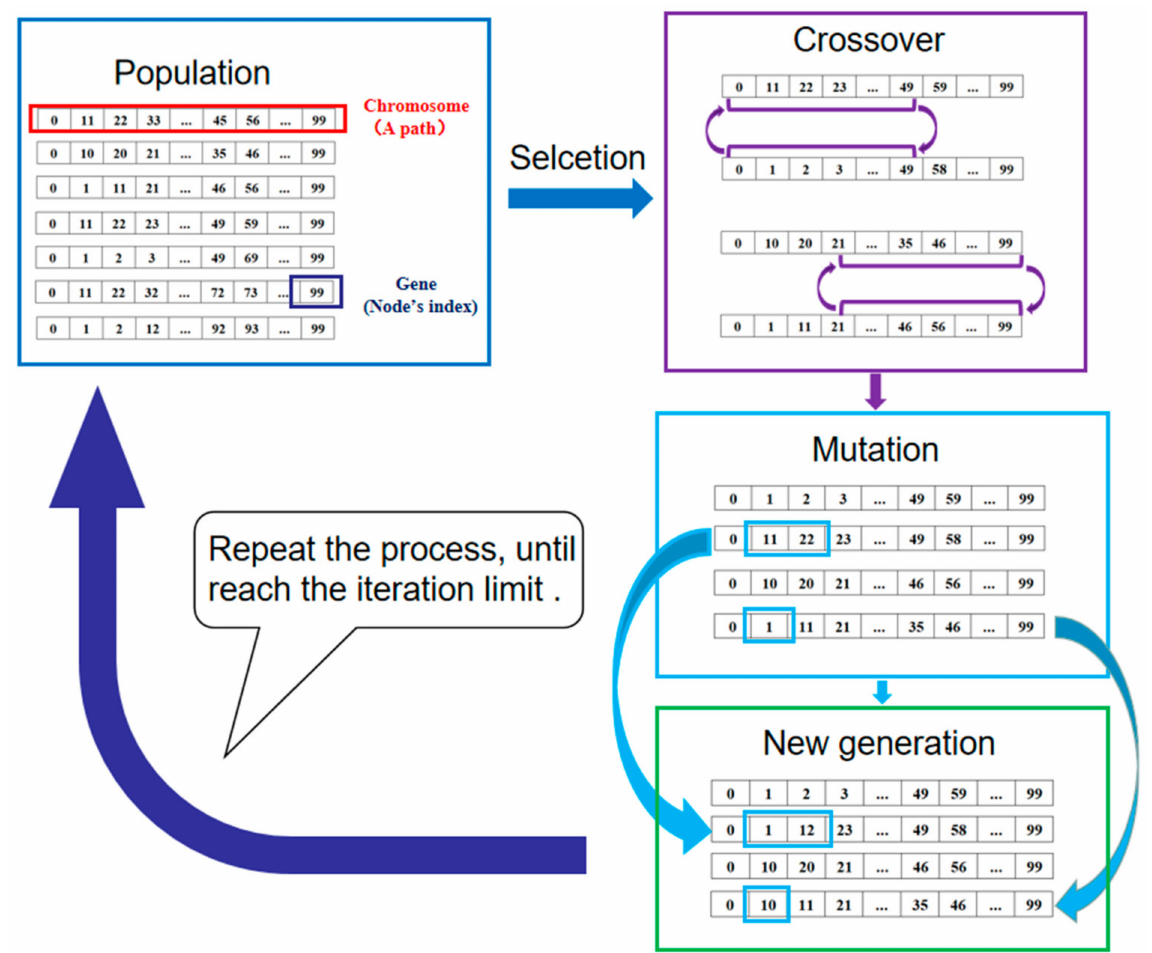
Figure 6. GA used in path